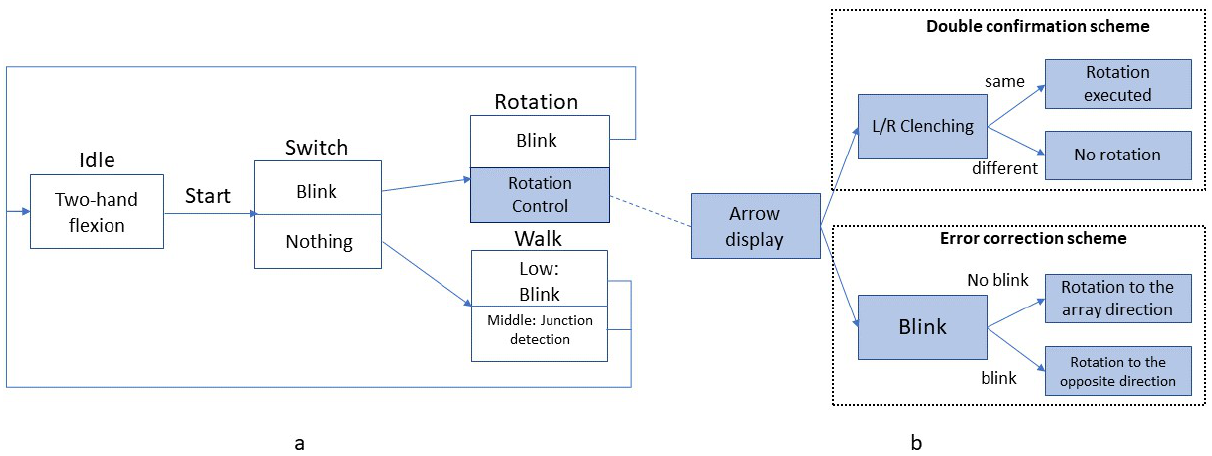
Figure 7. Navigation Control Diagram. ( a ): low- and middle-level control modes, ( b ): error con- trol strategies